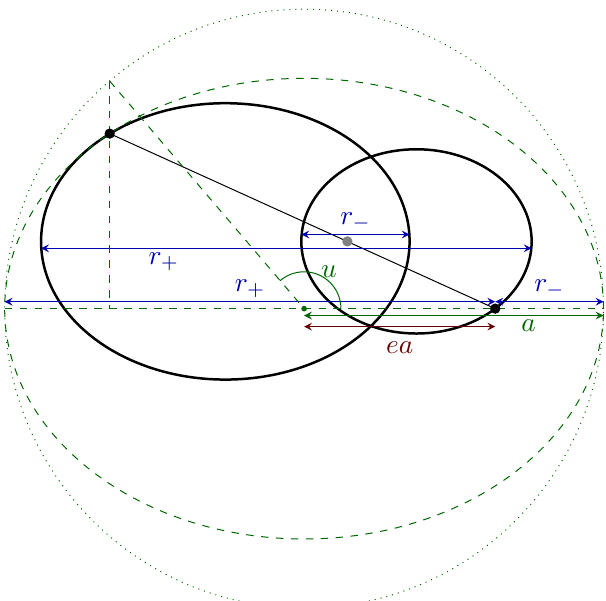
Figure 2. Bound elliptic motion in the center of mass frame (gray dot). The black ellipses mark the paths of each individual body. The heavier one lies on the focus of the green dashed ellipse, which describes the worldline of the lighter body in the companion’s reference frame. The dotted circle of radius a defines the eccentric anomaly, u , which can be used to paramaterize the orbit. See the text for a description of the orbital